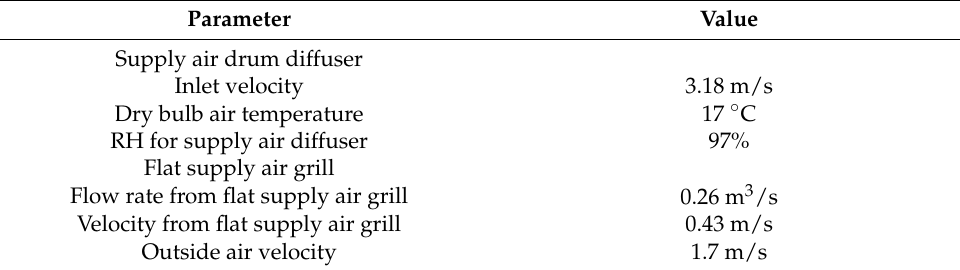
Table 3. Inlet conditions for drum diffusers and air